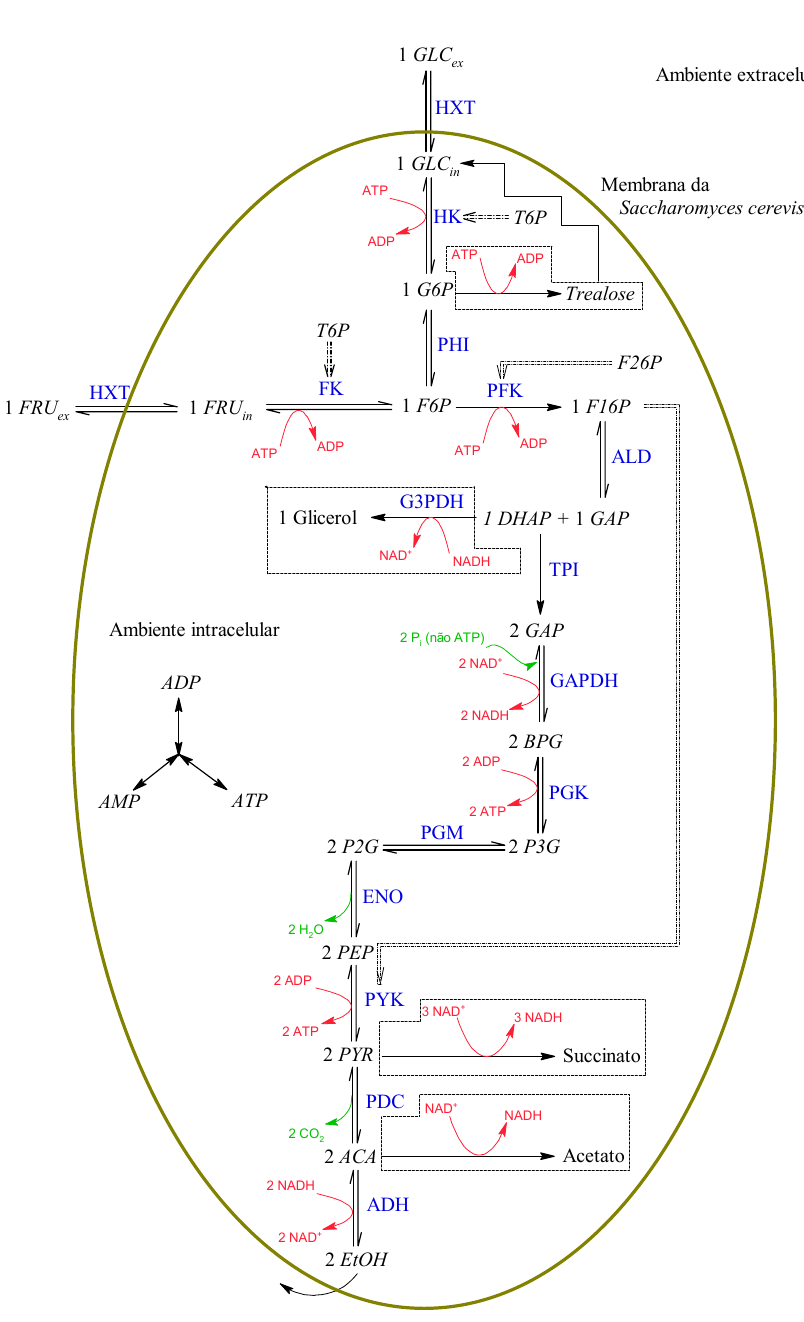
Figure 1. Stoichiometric representation of the selected metabolic route consisting of the EMP route followed by alcoholic fermentation. Source: prepared by the authors.